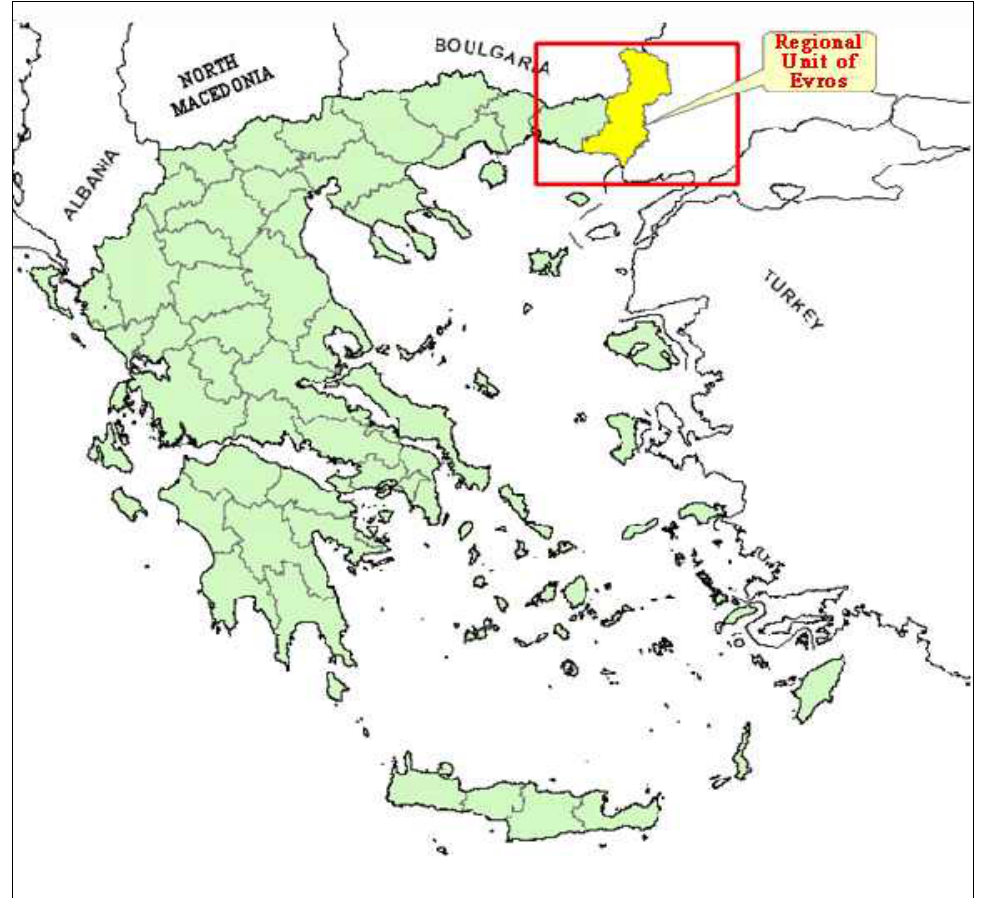
Figure 1. Study area.